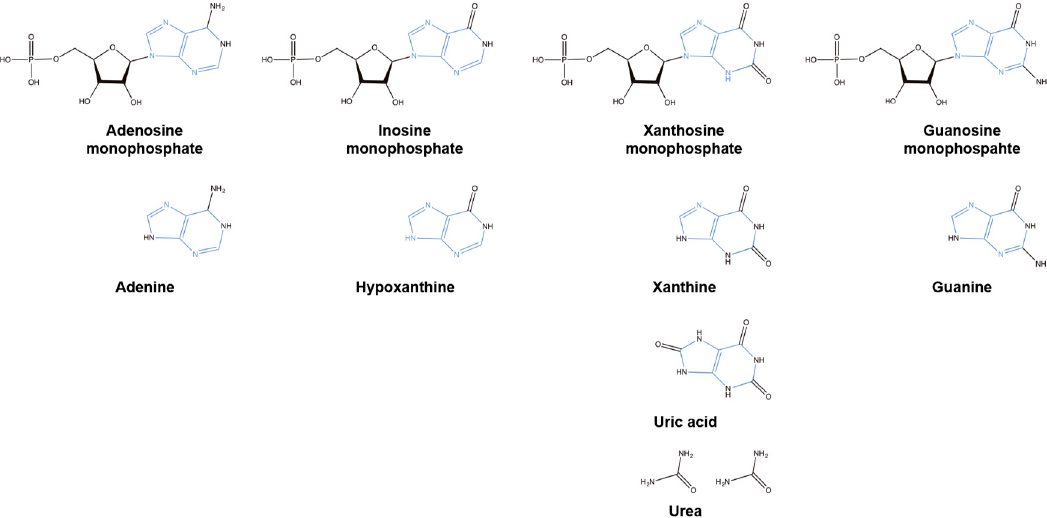
Figure 2. Structures of the key intermediates involved in de novo and salvage pathways containing a purine ring (blue) and the resultant non-purine breakdown product urea.